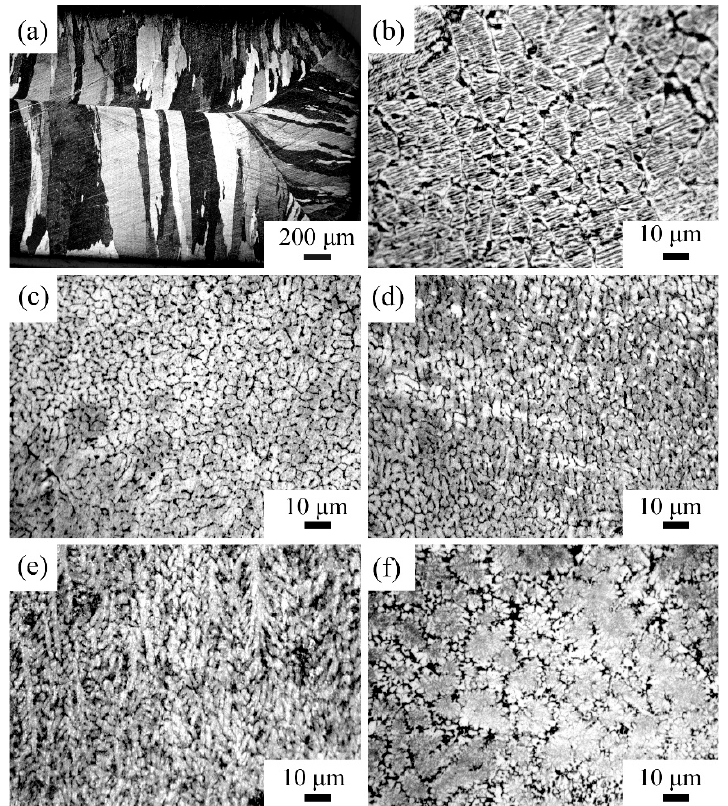
Figure 1. OM images of rapid cooling Zr-Co(-Al) alloys sheet microstructure: ( a ) Zr 50 Co 50 alloy; ( b ) Zr 48 Co 48 Al 4 alloy; ( c ) Zr 47.5 Co 47.5 Al 5 alloy; ( d ) Zr 47 Co 47 Al 6 alloy; ( e ) Zr 46.5 Co 46.5 Al 7 alloy; ( f ) Zr 46 Co 46 Al 8 alloy.